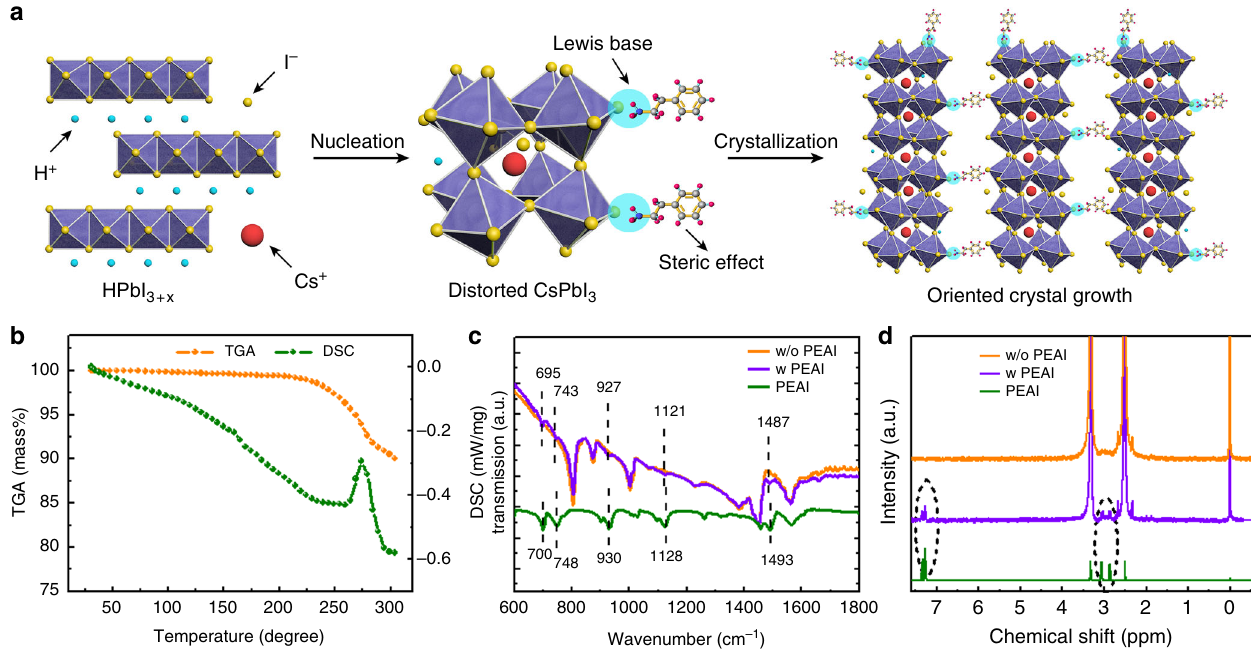
Fig. 3 Mechanism of HI/PEAI-induced phase stability: a Schematic for HI/PEAI additive-induced CsPbI 3 crystal growth. b TGA and DSC spectra for the CsPbI 3 fi lm with PEAI. c FTIR spectra, and d 1 H liquid-state NMR spectra for the related fi